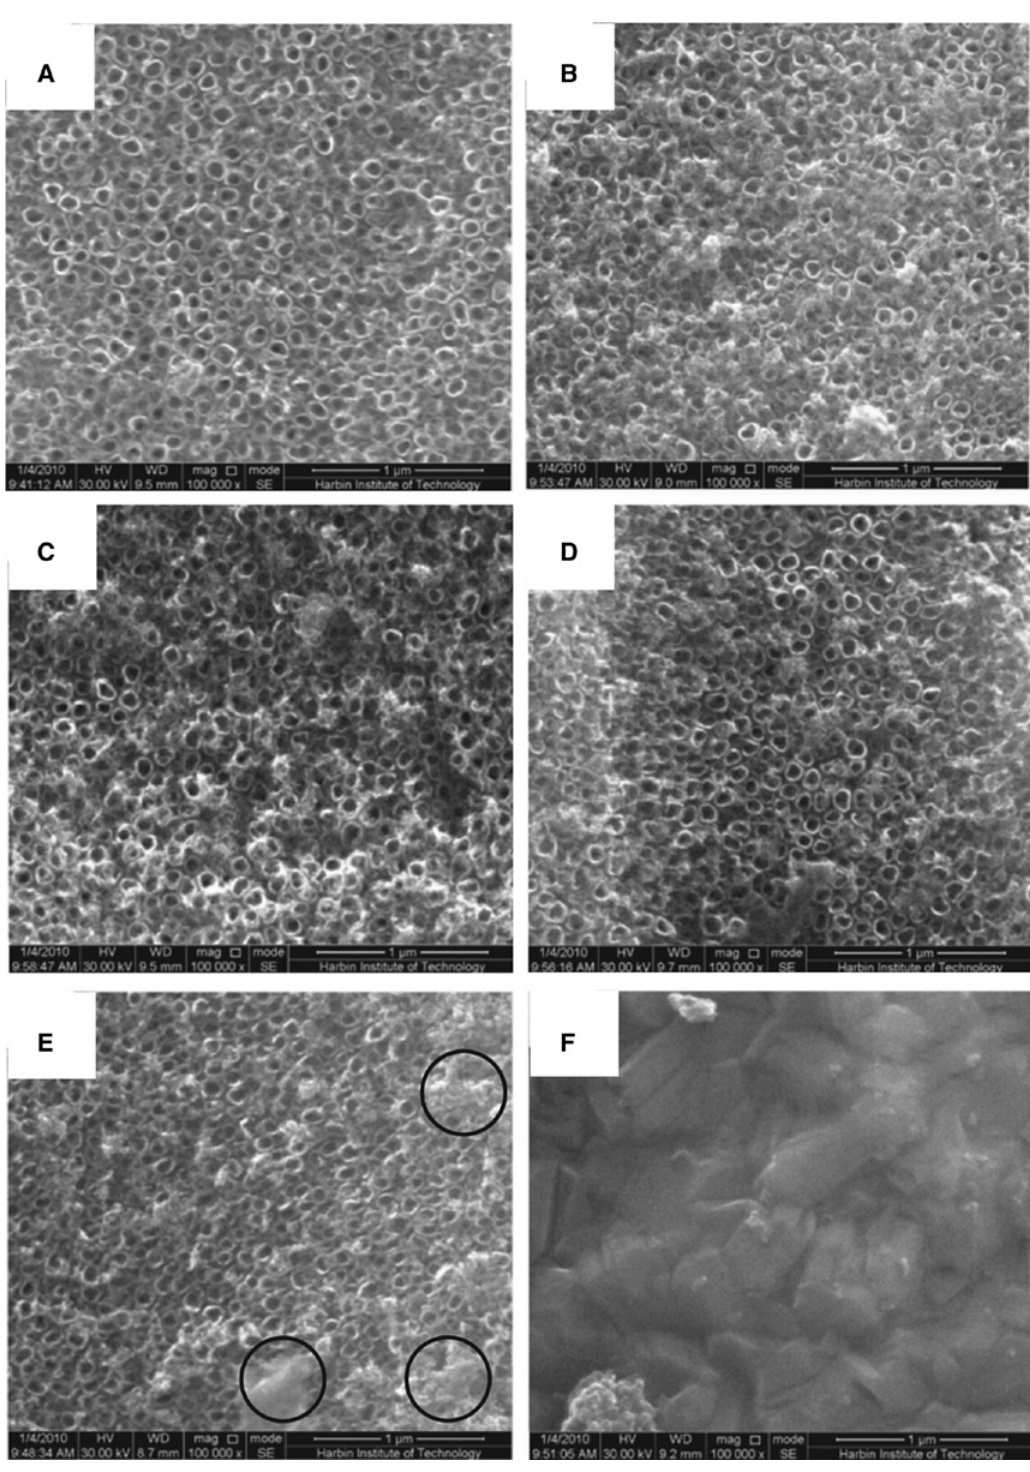
NTAs by electrochemical anodization in F - -based Na 2